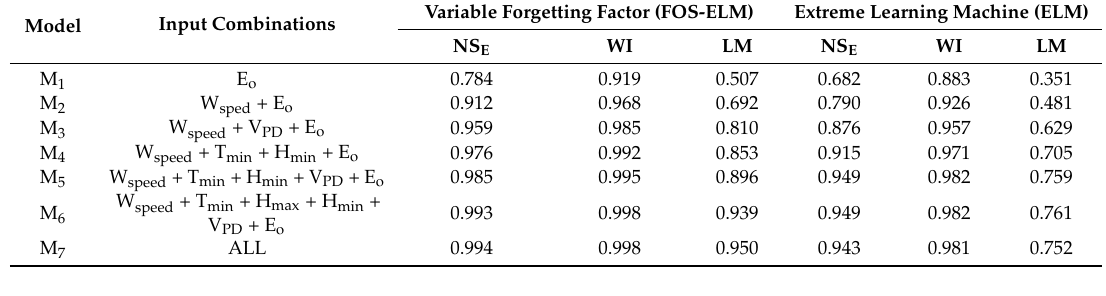
Table 2. Test modeling phase performance of FOS-ELM and ELM models using all the reported metrics. Note, the best model is boldfaced.